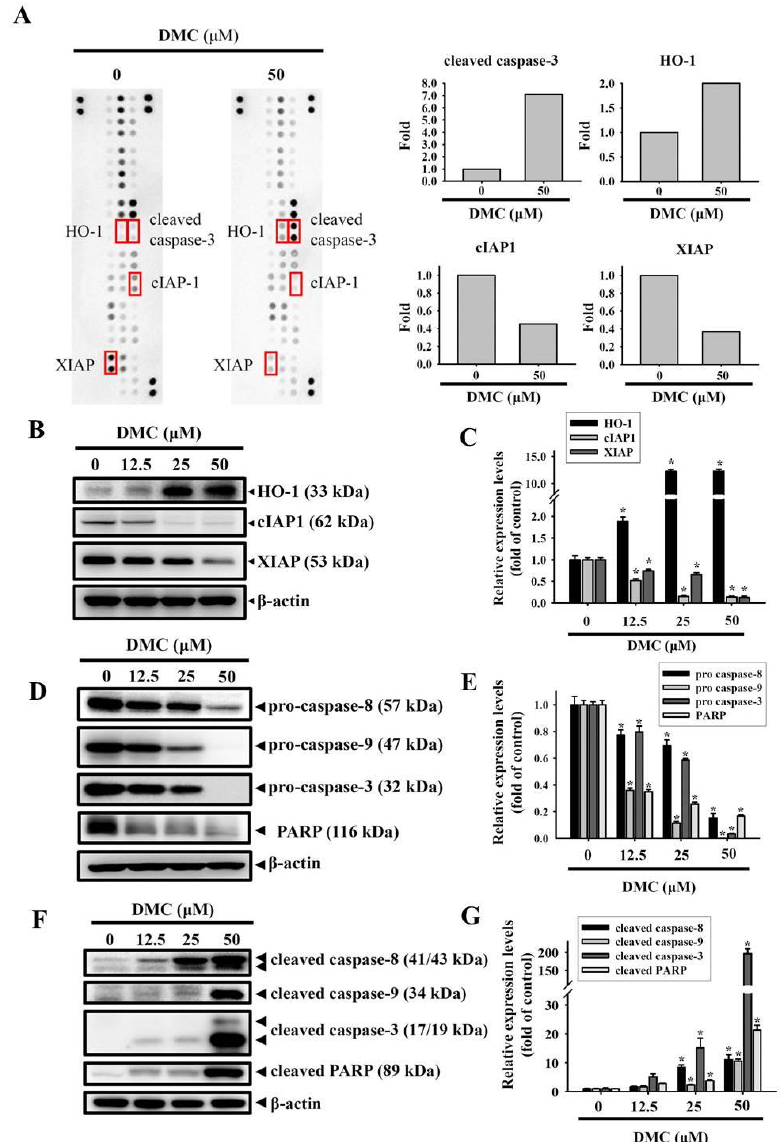
Figure 3. High-throughput screening of apoptosis-related proteins modulated by demethoxycurcumin (DMC) in oral squamous cell carcinoma (OSCC) cells. ( A , left panel) Representative images of the apoptotic protein array (R&D System) are shown for vehicle- and DMC-treated HSC-3 cells. ( A , right panel) Proteins involved in apoptosis and regulatory pathways were quantitated using an densitometer and are represented as multiples of change compared to the controls. ( B – G ) HSC-3 cells were treated with indicated concentrations of DMC for 24 h, and an Western blot analysis was used to detect the expression levels of heme oxygenase (HO)-1, cellular inhibitor of apoptosis 1